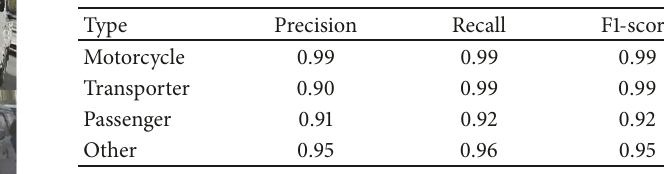
Table 4: Classification precision, recall, and f1-score of pretrained CNNs based on sheared dataset.